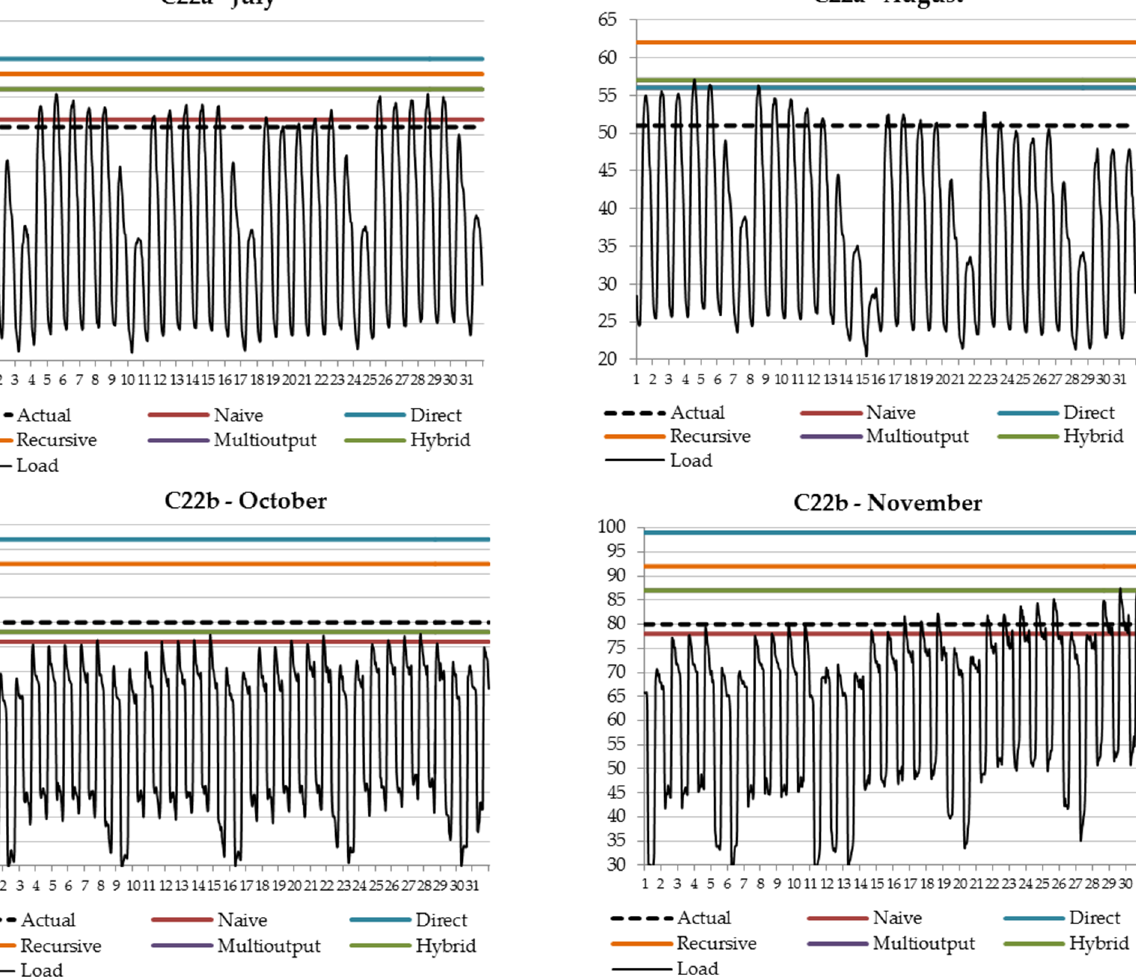
Figure 6. Exemplary consumed loads versus optimized contracted capacities based on the investigated methods for customers C22a and C22b. Note: Hybrid and multiple-output methods overlap.